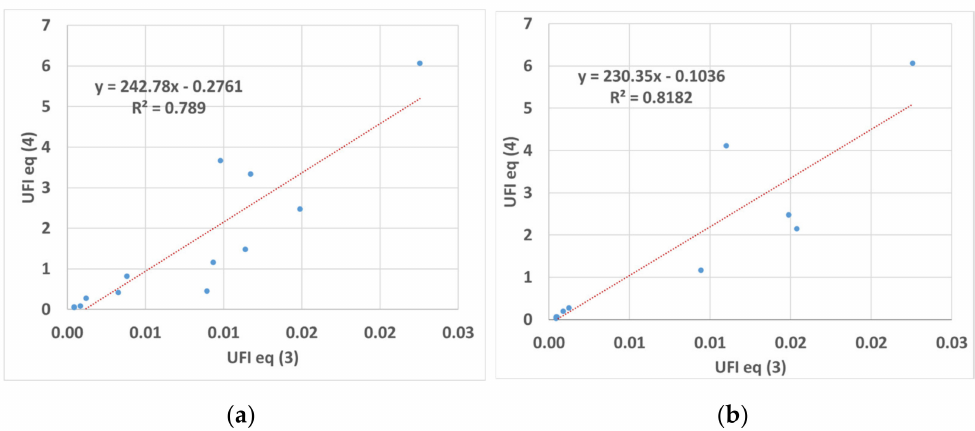
Figure 6. Relationship between the UFI indices calculated with Equations (3) and (4) for the protected areas of the Natura 2000 Network in Extremadura: ( a ) SPAs and ( b )